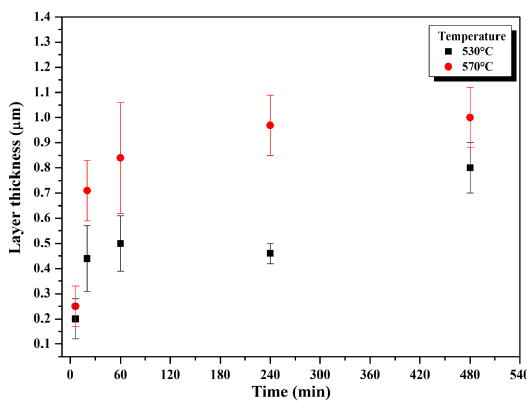
Figure 5. Graphical representation of oxide layer thickness (µm) for all evaluated